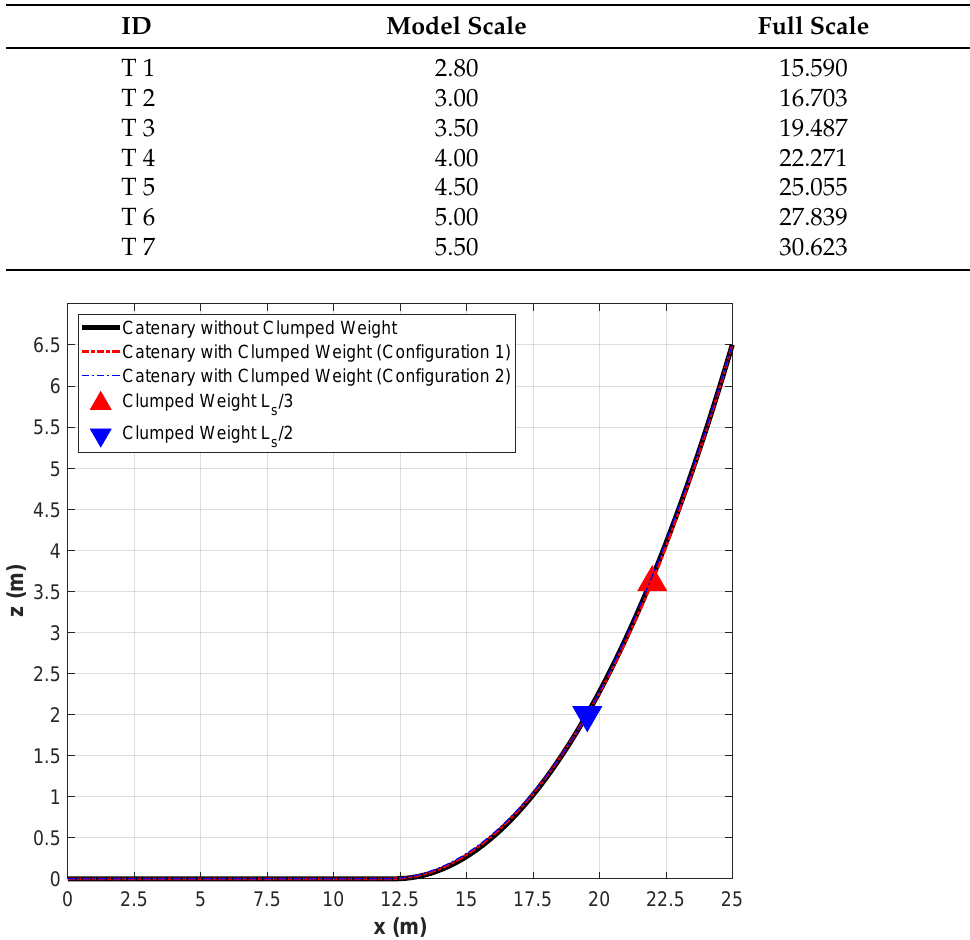
Figure 8. All three tested configurations. Note: the three lines are almost overlapping, the catenary shape is slightly changed in each